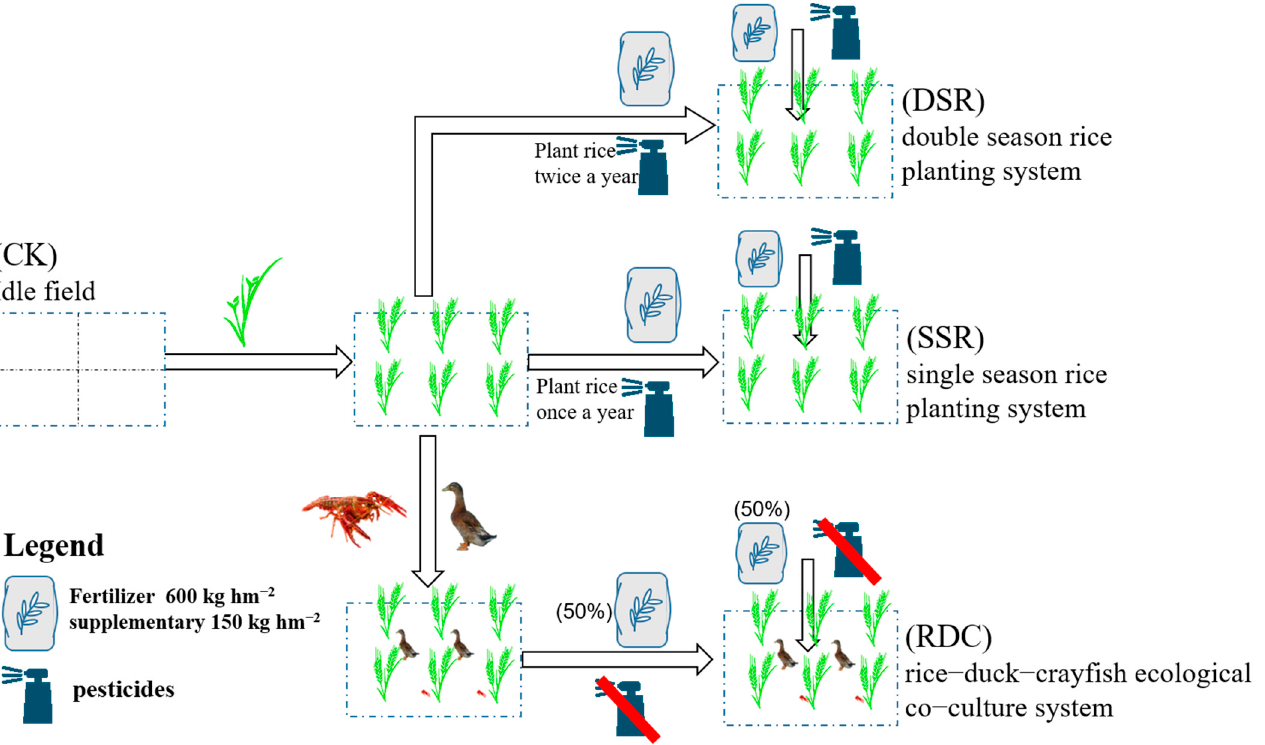
Figure 2. The general scheme of the field experimental designs.